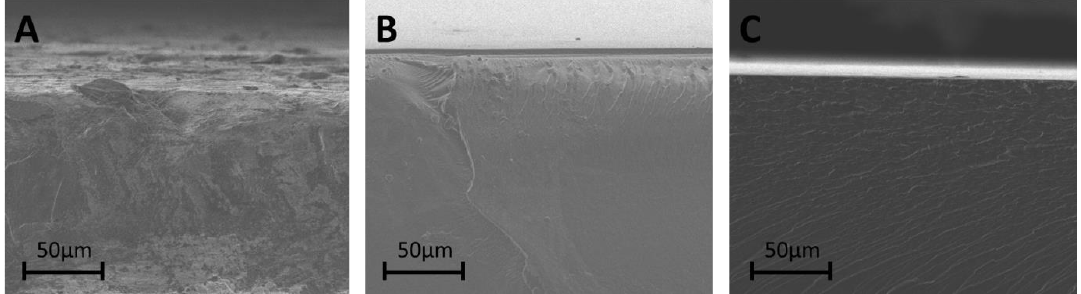
Figure 5. SEM cross-section micrographs of: ( A ) pristine PVA membrane, ( B ) PVA-SSA membrane containing 23 wt.% SSA heated at 140 °C, and ( C ) PVA-SSA membrane containing 33 wt.% SSA heated at 140 °C.